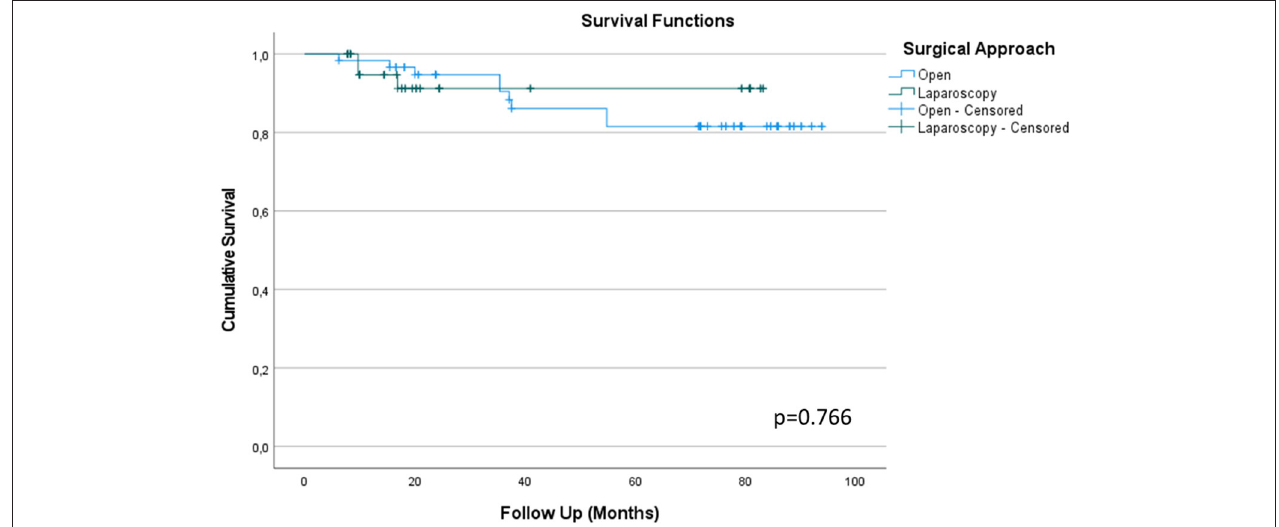
FIGURE 1 | Kaplan-Meier survival comparison between Open and Laparoscopy surgical approach to Radical Nephroureterectomy for Upper Tract Urothelial Cancer (UTUC) based on cancer specific survival at long term